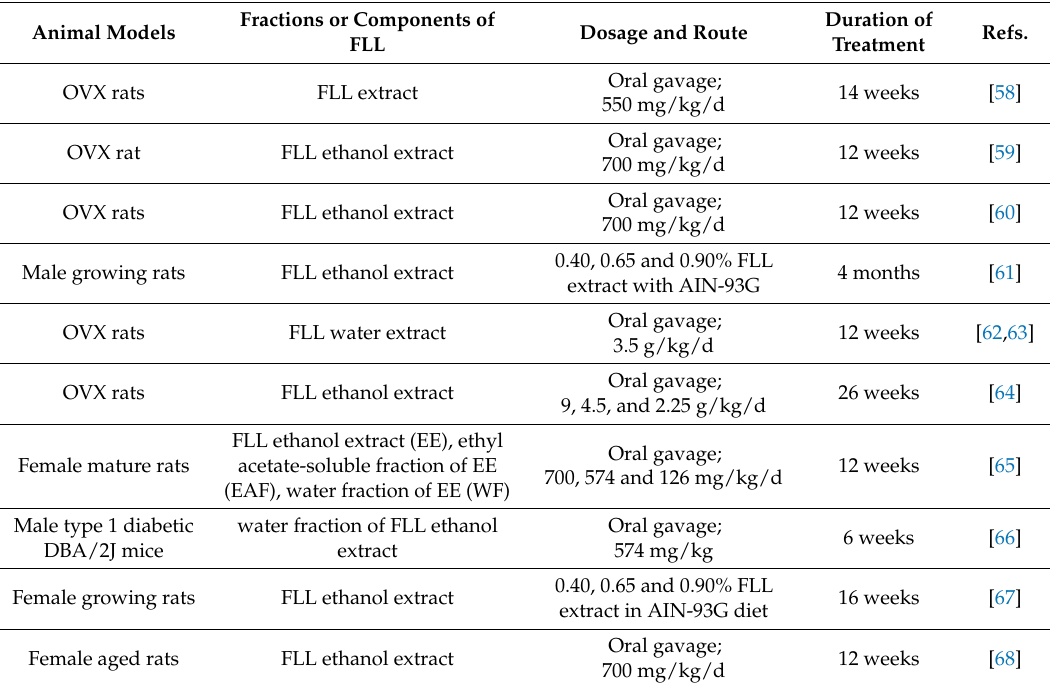
Table 1. Animal models employed in studying the effect of Fructus Ligustri Lucidi on bone remodeling. Animal